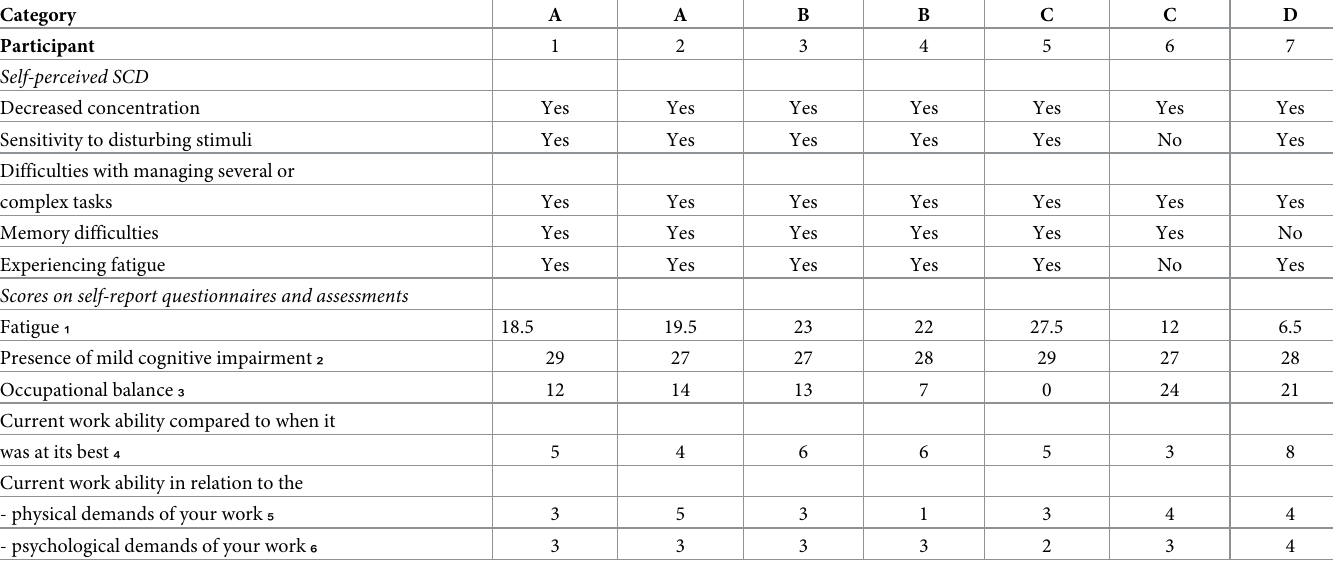
Table 3. Subjective cognitive difficulties and scores on self-report questionnaires in the four categories of the participants (n = 7).